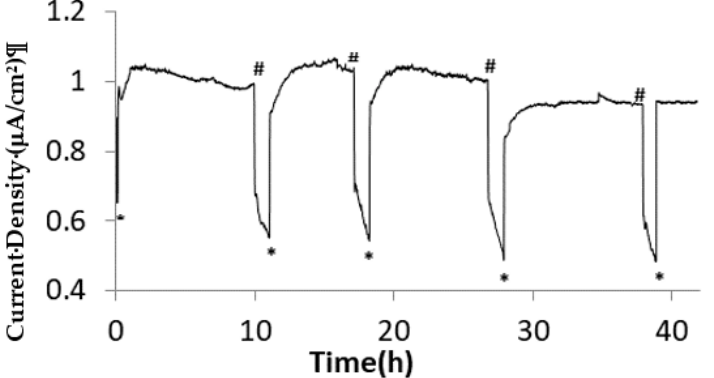
Figure 3. Electro-catalytic performance in oxygen generation from water, with and without light illumination (0.25 sun), of PEDOT/nano Co 3 O 4 /rGO nanocomposite deposited on Pt/FTO, where the polymerization mixture contained 110 mg of nano-Co 3 O 4 and 2.0 mg of rGO. Conditions: applied bias on the nanocomposite electrode of 0.80 V (vs. Ag/AgCl) in 0.2 M Na2SO4 (pH 12) (* = ‘light on’, # = ‘light